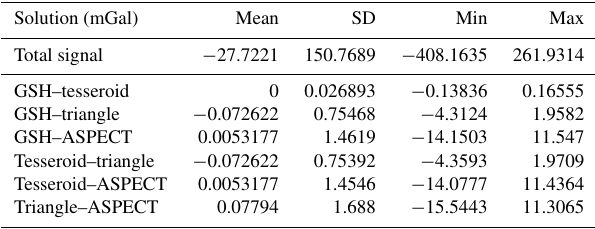
Table 3. Statistical results from shell test 3: a density shell of equal thickness is modelled with a density contrast at the CRUST1.0 Moho